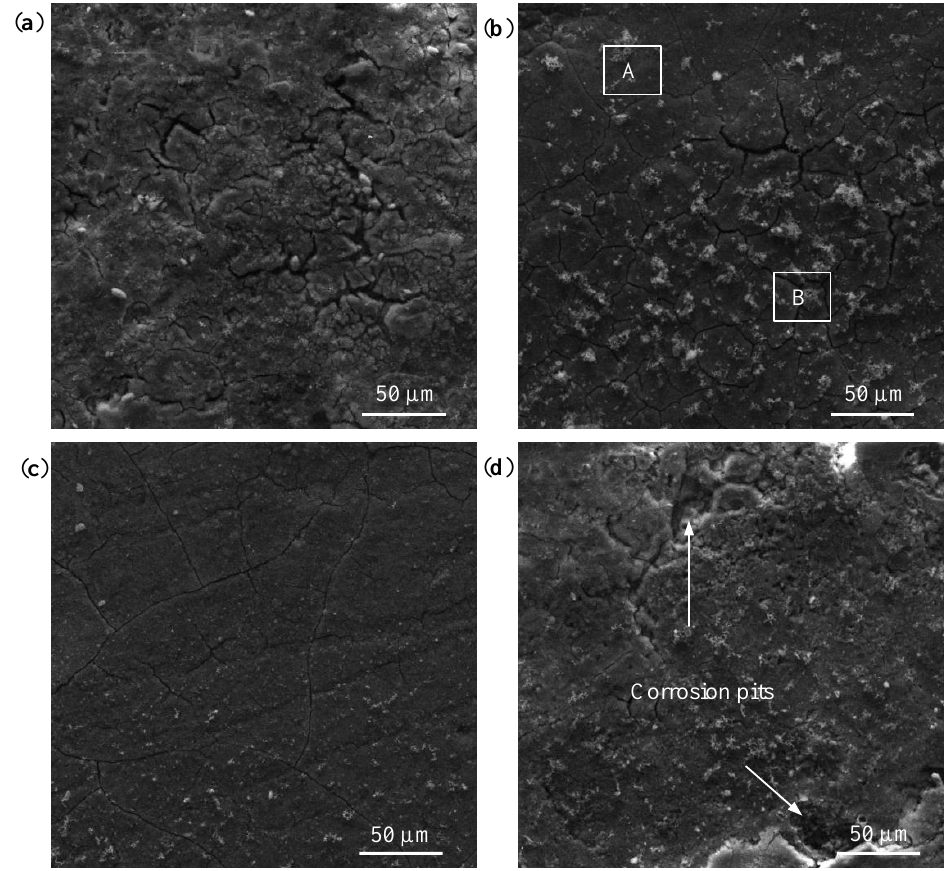
Figure 5. SEM micrographs of rapid laser-melted Mg- x Mn alloys after immersion in SBF at 37 °C for 48 h: ( a ) pure Mg; ( b ) Mg-1Mn, area A was covered with integrated protective film, while area B presented relatively shallow cracks; ( c ) Mg-2Mn; ( d ) Mg-3Mn.